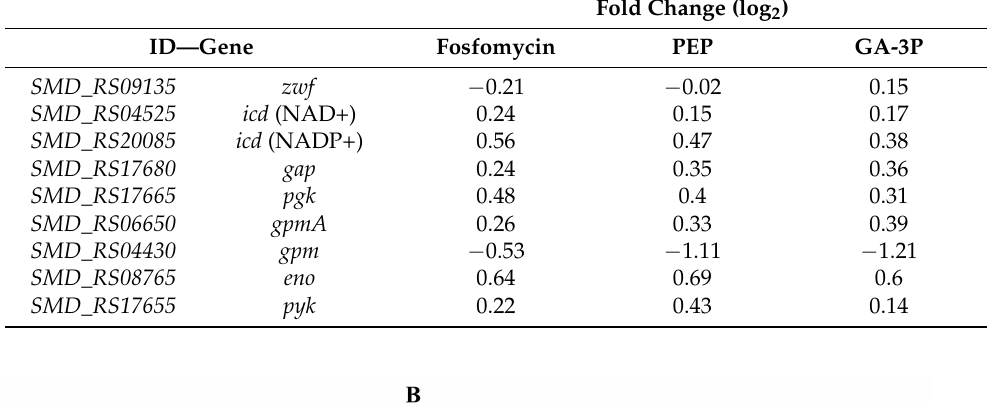
Table 5. Expression of the genes encoding the main S. maltophilia dehydrogenase enzymes and the lower glycolysis enzymes in the presence of fosfomycin, PEP, or GA-3P.